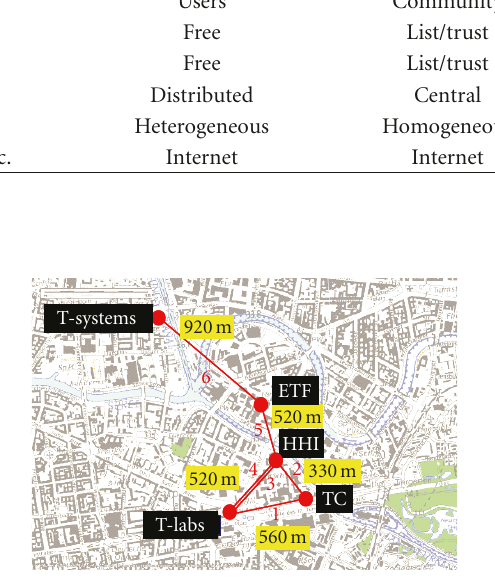
Figure 2: MagNets WiFi backbone in the heart of